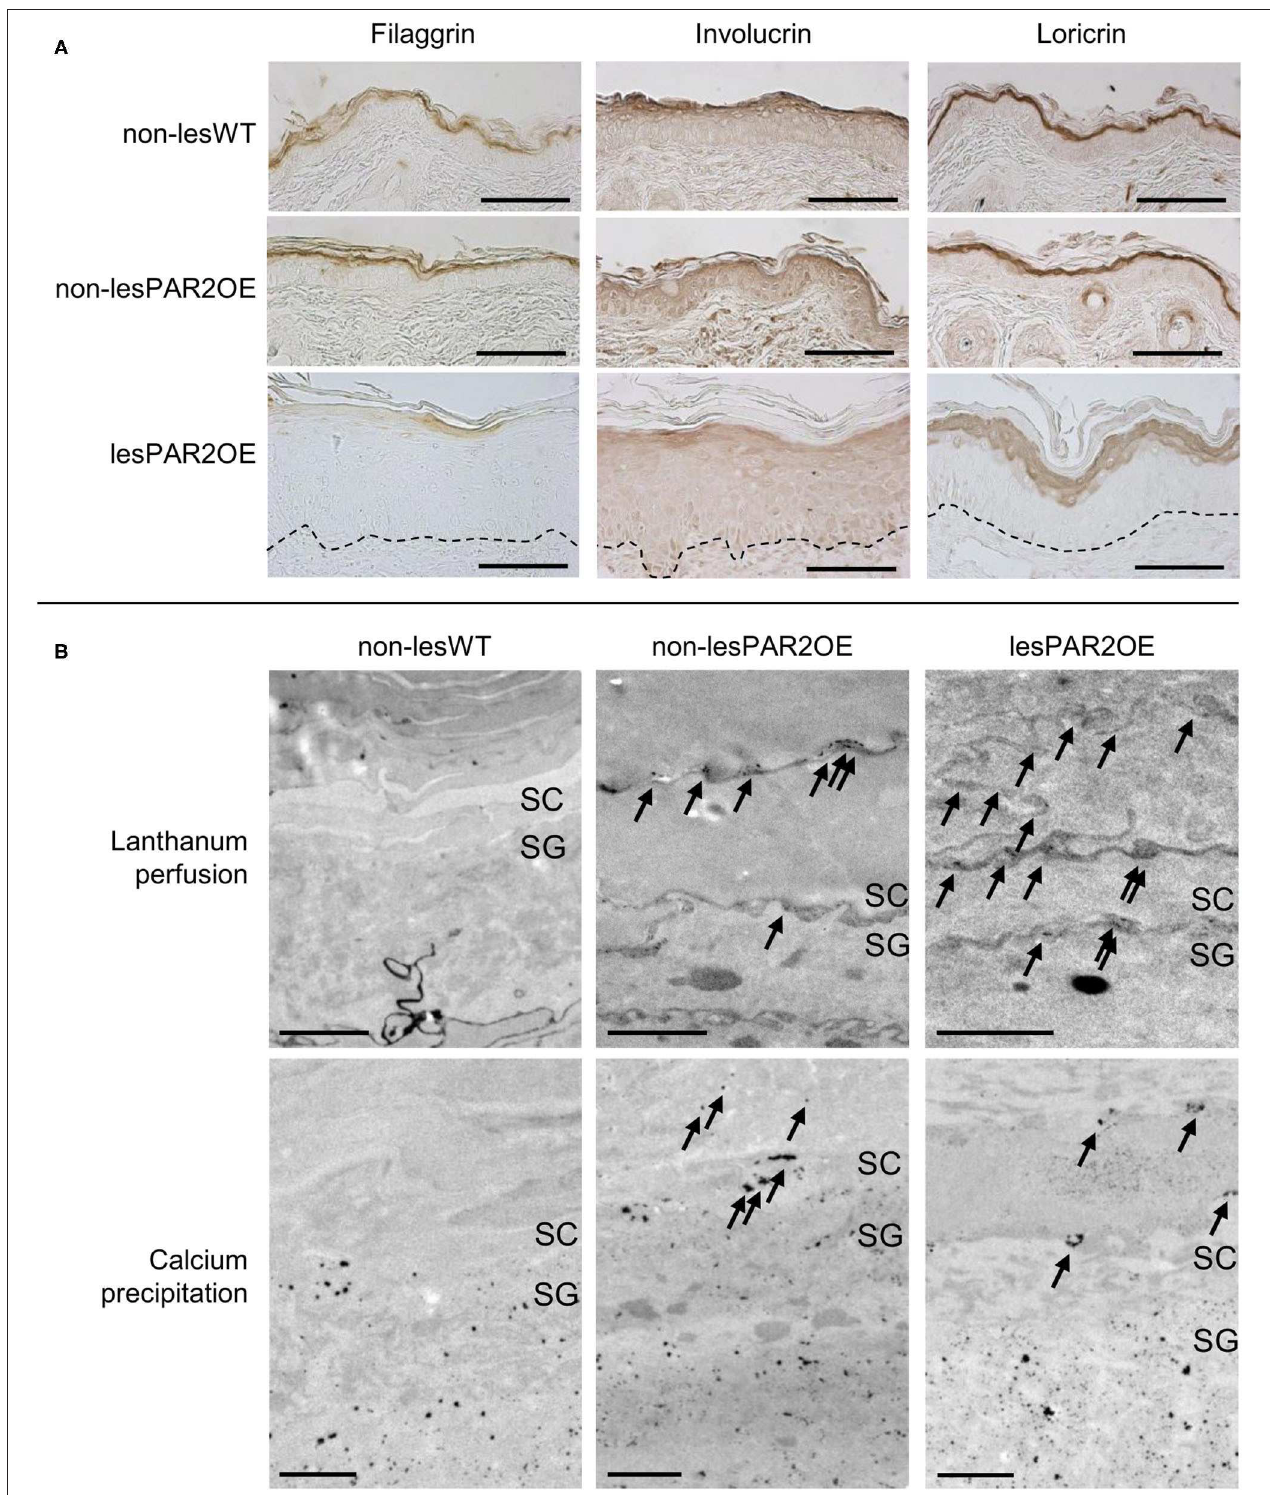
FIGURE 3 | Structural impairment of barrier function in PAR2OE mice. (A) Immunohistochemical staining for filaggrin, involucrin, and loricrin in lesional and non-lesional skin of PAR2OE mice, as well as WT mice (representative of n = 4, age-matched 12-weeks-old mice). Manually drawn dashed line marks the basement membrane. Bars represent 100 µ m. (B) Electron microscopy images are shown after lanthanum perfusion (upper row). Arrows mark intercellular lanthanum deposition in the SC in non-lesional and lesional PAR2OE skin. Calcium precipitation (lower row) was found in the SC in non-lesional PAR2OE and lesional PAR2OE skin (arrows). Bars represent 1 µ m. SC, Stratum corneum; SG, Stratum granulosum.